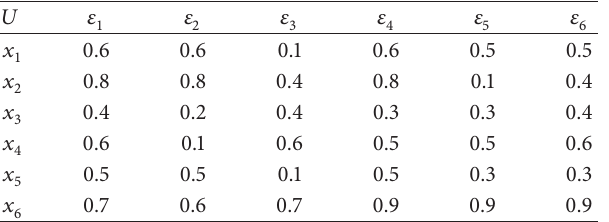
Table 2: Tabular representation of (𝐹,𝐴) .